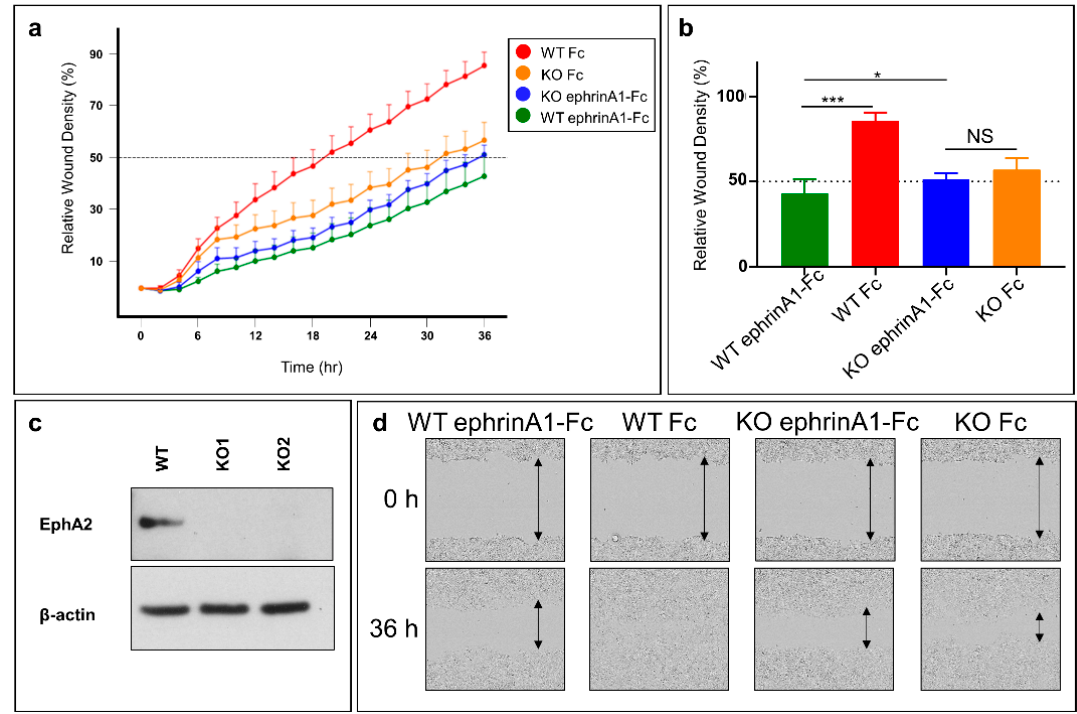
Figure 4. Genetic inhibition of EphA2 expression impairs migration of pancreatic cancer cells. ( a ) Real-time cell migration assay. WT and EphA2-KO BxPC3 cells were scratched and treated with either ephrinA1-Fc or Fc. Cells were left to heal for 36 h inside the IncuCyte S3 live-cell imager. WT cells treated with Fc migrated significantly faster than WT cells treated with ephrinA1-Fc (1 μ g/mL). Moreover, knocking out EphA2 significantly reduced cell migration. However, treating EphA2-KO cells with ephrinA1-Fc did not have a significant additive effect on reducing cell migration. ( b ) Histogram of relative wound density at 36 h. ( c ) Validation of knocking out EphA2 using CRISPR-Cas9. WT and KO1 cell lines were used for the scratch assay. ( d ) Representative images of different scratches at times 0 and 36 h. *, p < 0.05; ***, p < 0.0001. Error bars represent standard deviation.